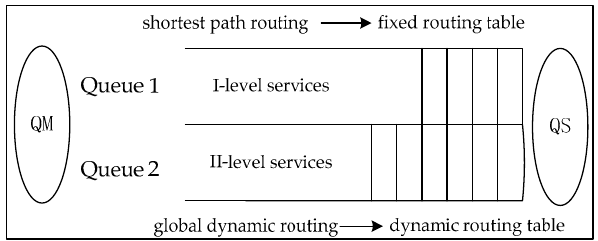
Figure 3. Fundamental structure of the node queue. QM: Queue Management; QS: Queue Scheduling.